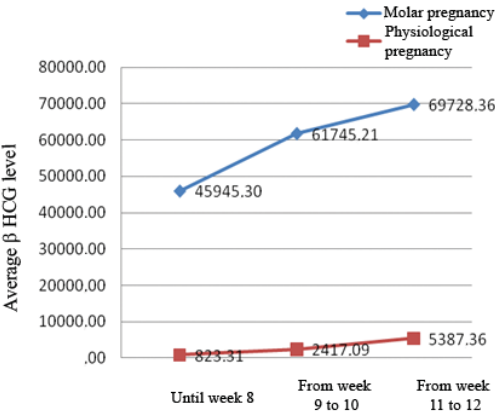
FIGURE 1. Average β HCG levels in the groups according to a gestational age